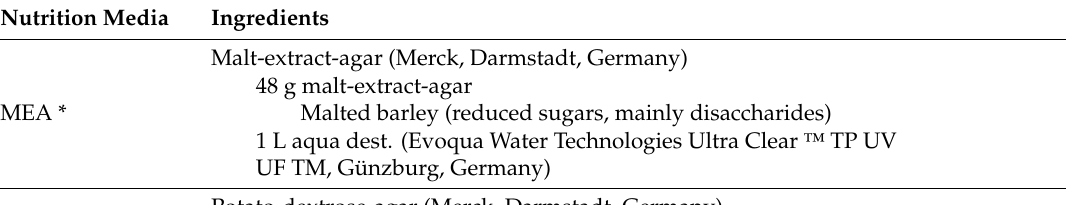
Table 1. Nutrition media and their